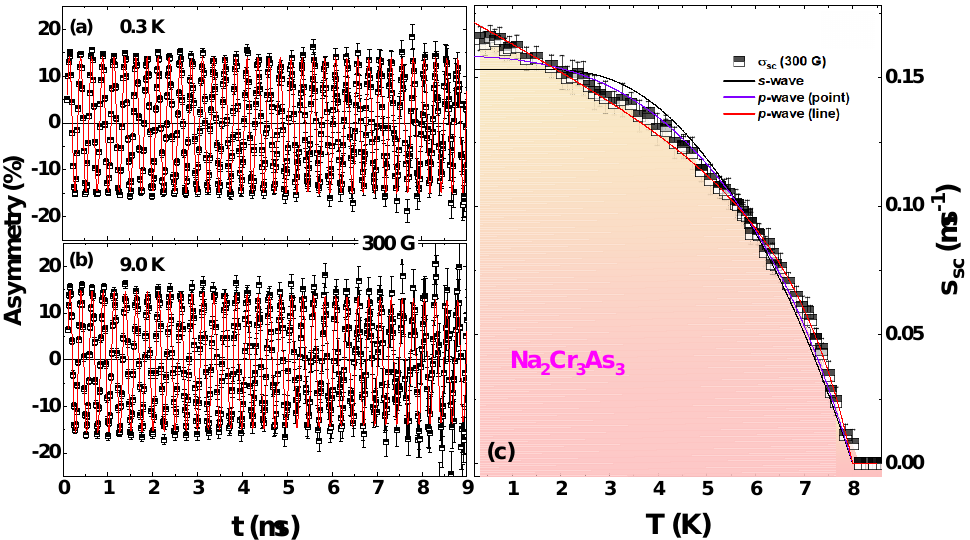
Figure 2. (Color online) The transverse field µ SR time spectra for Na 2 Cr 3 As 3 collected ( a ) at T = 0.3 K and ( b ) at T = 9.0 K in an applied magnetic field H = 30 mT in the field cooled state. ( c ) The temperature variation of muon depolarization rate σ sc ( T ) (symbols). The lines through the data points are the fits with different gap models (see text). The black line shows the fit using an isotropic single-gap s -wave model with 2 ∆ ( 0 ) / k B T C = 4.21 ( ∆ ( 0 ) = 1.45(2) meV). The solid red line and the violet line represent the fit to a p -wave line node and p -wave point node model with 2 ∆ ( 0/ k B T C = 9.14 ( ∆ ( 0 ) = 3.15(6) meV) and 2 ∆ ( 0/ k B T C = 5.22 ( ∆ ( 0 ) = 1.80(3) meV), respectively. The shaded region covers the region of the nodal p -wave line